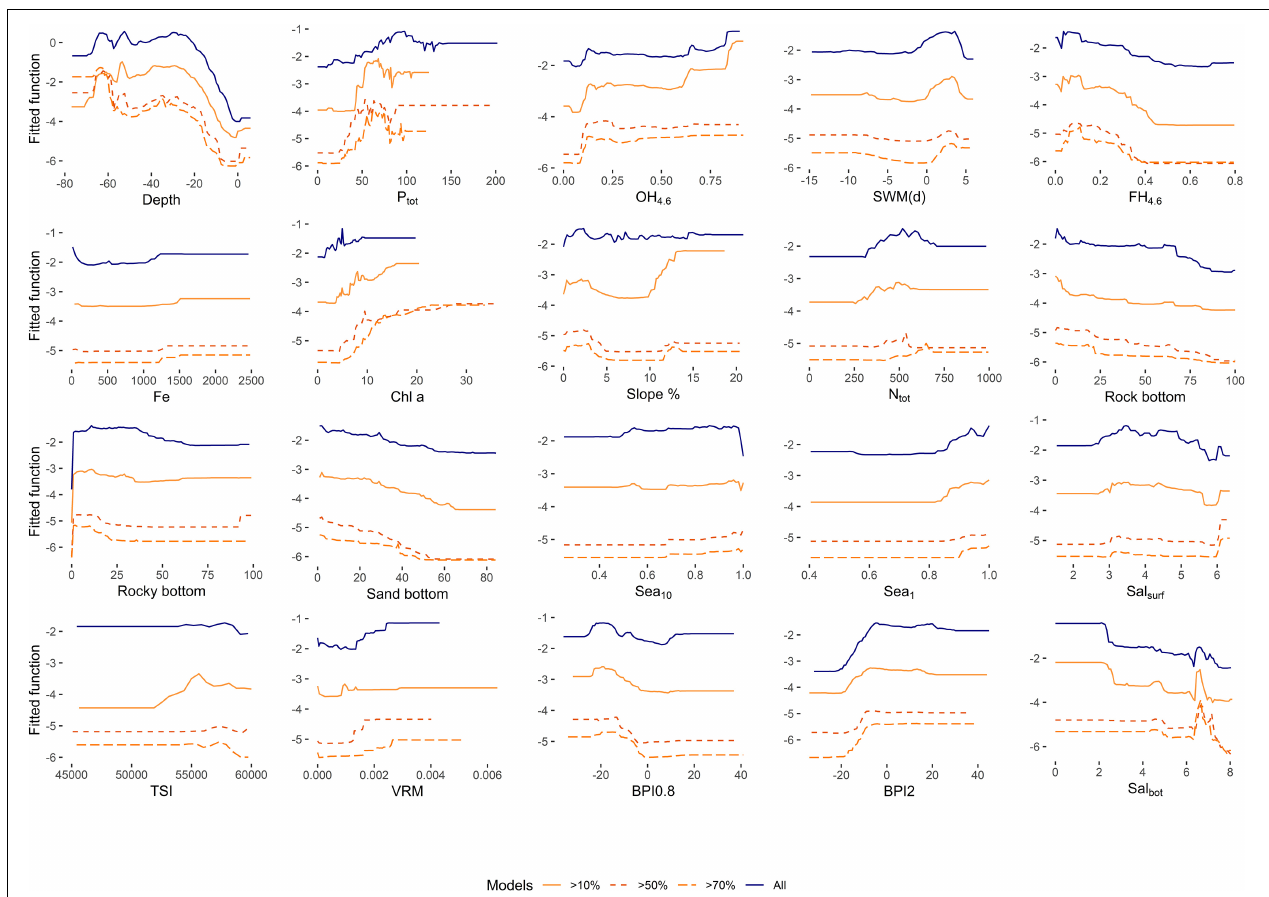
FIGURE 5 | Partial dependence plots of predictors in the concretion occurrence